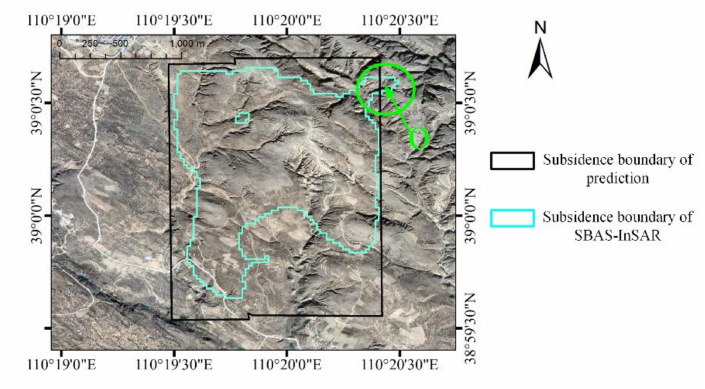
Figure 10. Subsidence boundary by SBAS-InSAR and the subsidence boundary by prediction (the green circle represents the area where InSAR boundary is beyond the prediction